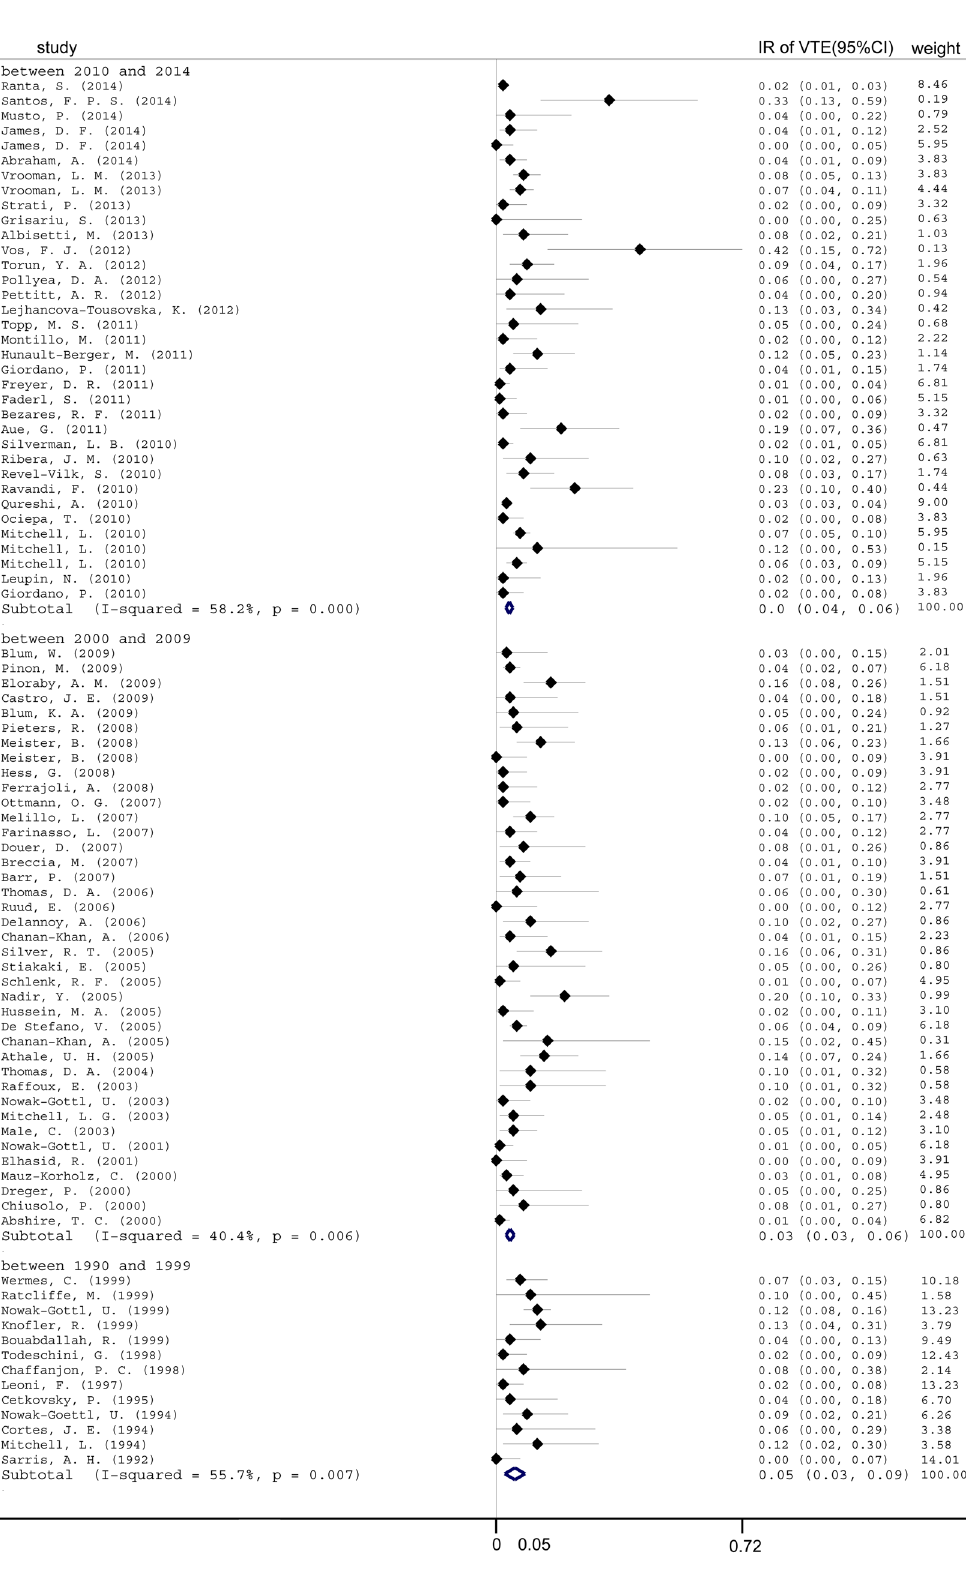
Figure 7. Pooled incidence of venous thromboembolism subgrouped according to publication year. IR = incidence rate. VTE = venous